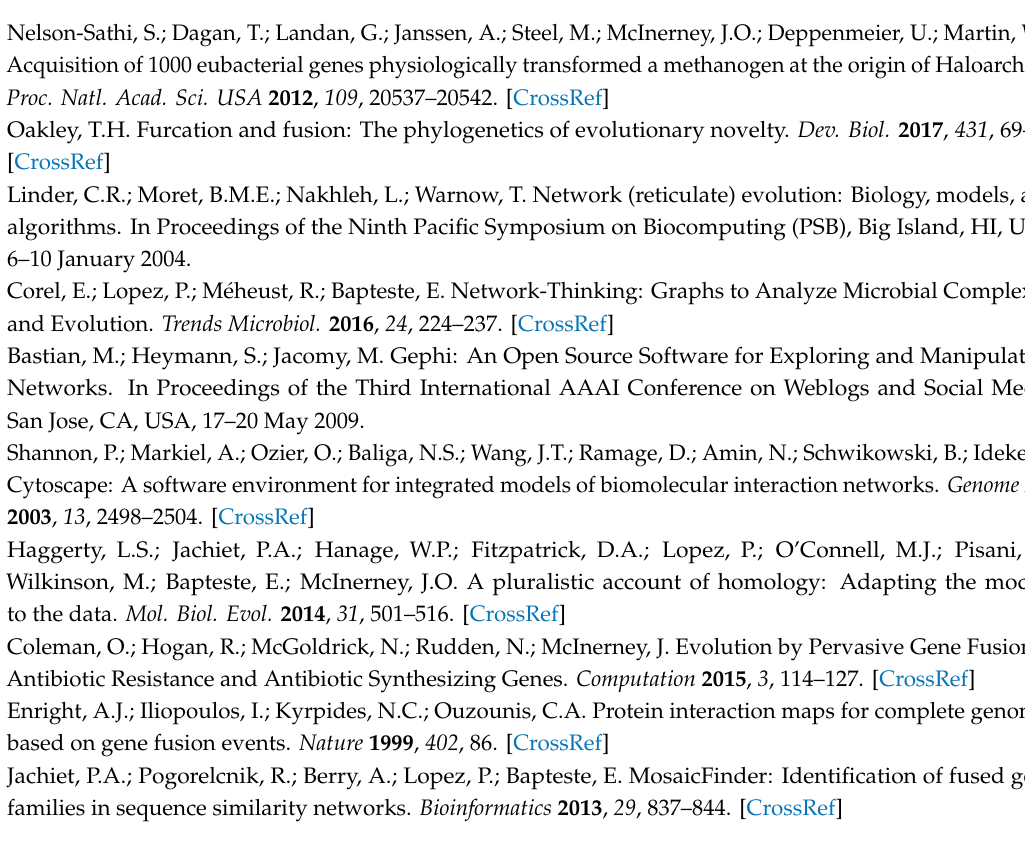
Figure S1: Numbers of OR, corrected upper 95% CI and lower 95% CI value across all GO annotations, Table S1: Numbers of composite and non-composite genes from eukaryotes and prokaryotes in di ff erent functional categories, OR, corrected upper and lower 95% CI